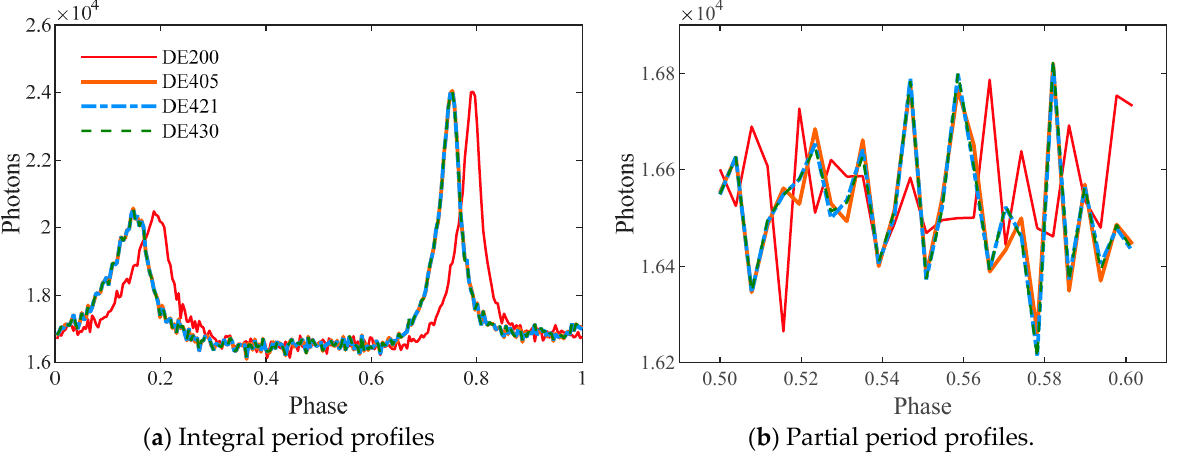
Figure 3. Comparison of standard pulse profiles. The number of profile bins is 256. The profiles of DE405, DE421 and DE430 in ( a ) basically coincide. ( b ) shows the profile difference during the period this interval).